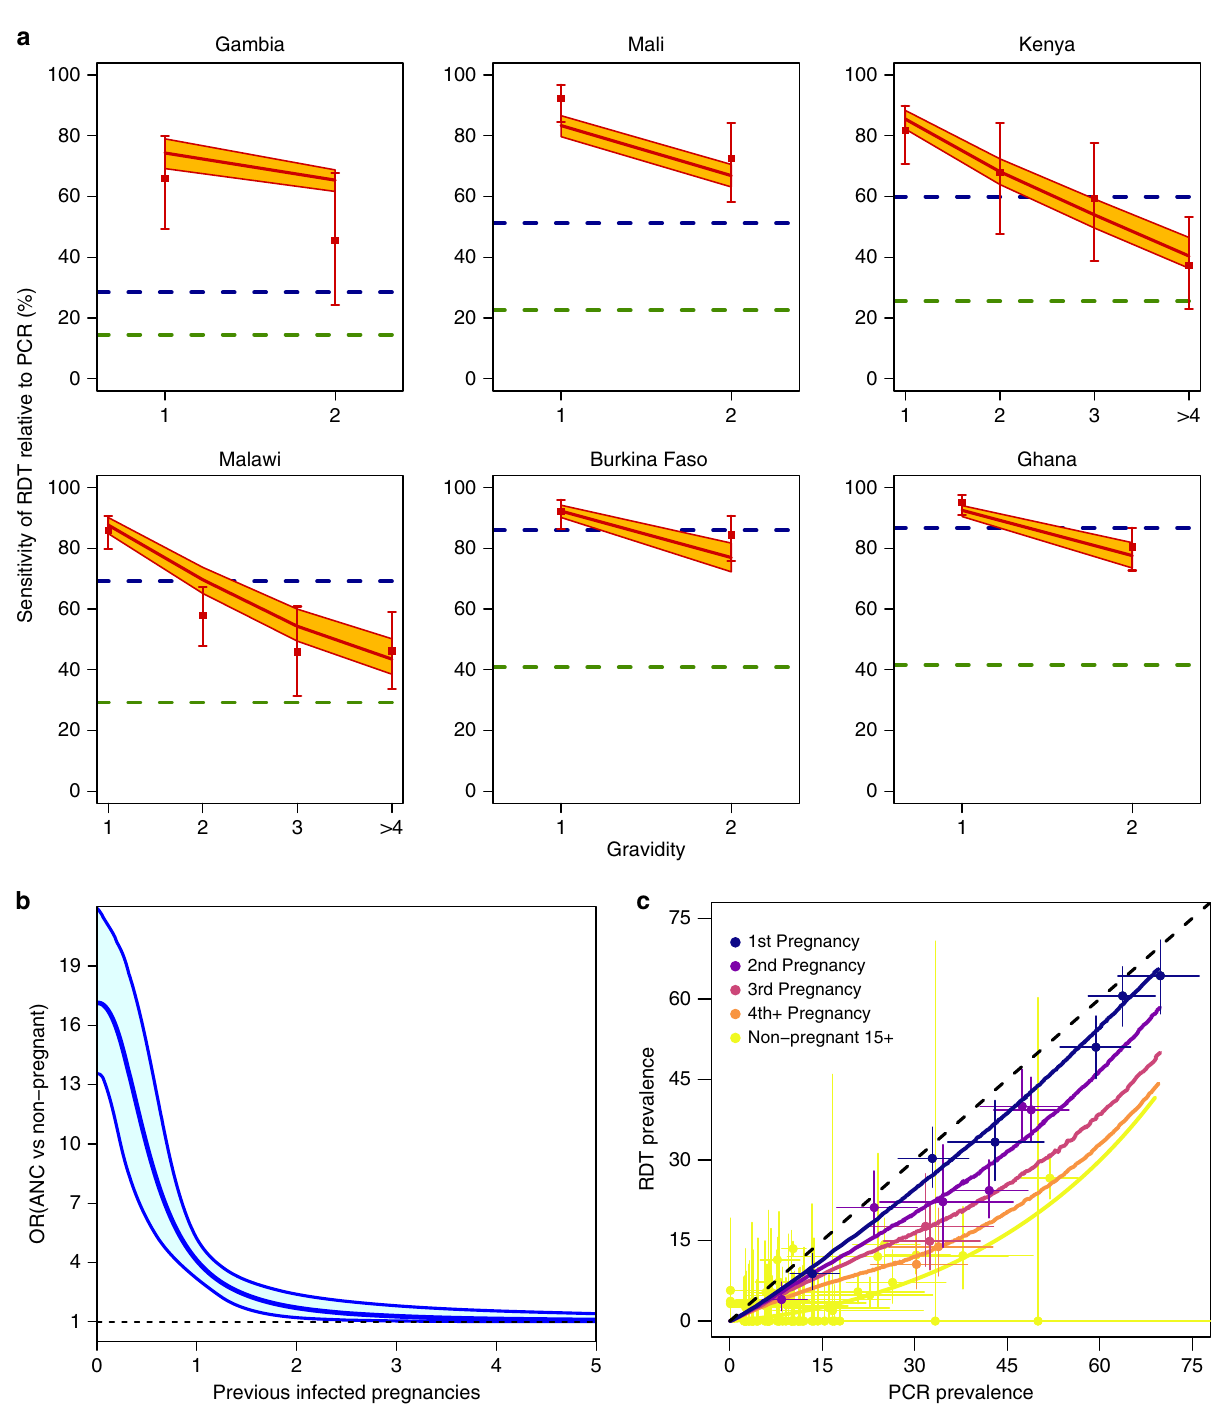
Fig. 2 Comparing RDT performance at enrolment in ISTp trials to outside of pregnancy. Figure shows a RDT sensitivity relative to PCR by gravidity across each of the six study countries (ordered by PCR prevalence in primigravidae), red dots and error bars show mean and 95% CI for RDT sensitivity within the trials. For comparison, the estimated sensitivity in non-pregnant individuals (male or female) aged >15 years old (green dashed line) and for children under 5 years old (blue dashed line) based upon the relationship between transmission and RDT sensitivity from Wu et al. 22 are also shown. The red line and orange polygon show the mean and 95% CIs for the best fi tting model incorporating a declining boost in detectability of infection with RDT dependent upon the level of exposure in previous pregnancy, b shows the fi tted relationship (see “ Methods ” section) from this model (blue line shows median and polygon 95% CI) of the odds ratio of detection at enrolment and non-pregnant individuals (male or female) aged >15 years old and c yellow dots and line show the data and the fi tted relationship between PCR and RDT prevalence in non-pregnant individuals (male or female) aged >15 years old from Wu et al. 22 . Remaining colours show the estimated relationship between gravidity-speci fi c PCR prevalence and RDT prevalence from this model (lines) compared to the data (dots with horizontal and vertical bars showing 95% CI for PCR prevalence and RDT prevalence,